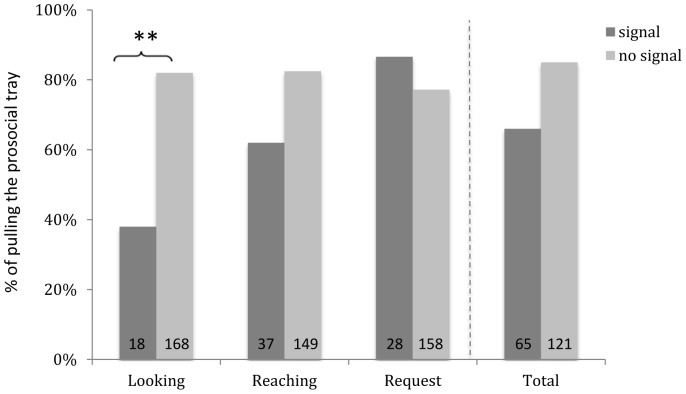
Effect of signs and signals of need on prosocial pulling.Percentage of trials in which prosocial pulling occurred following different kinds of signaling (dark bars) or without signaling (light bars). Figures inside the bars represent numbers of trials. For instance, prosocial pulling occurred in 85% of 121 trials in which no signaling of any kind occurred (total). Looking = recipient looks at reward; reaching = recipient tries to access reward with arm, request = recipient verbally asks for reward.